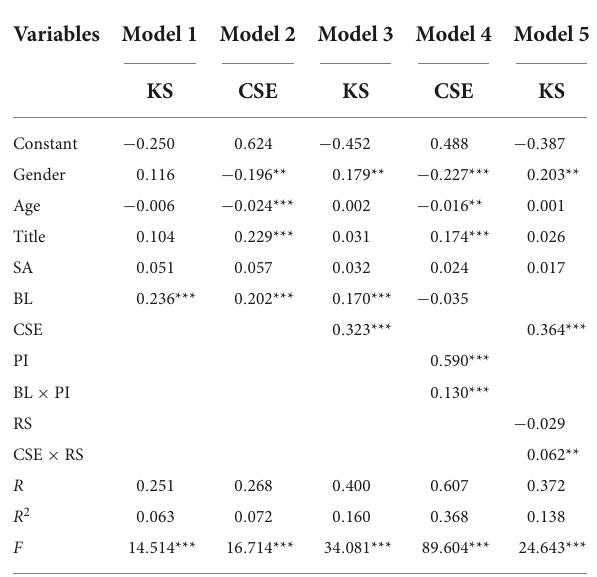
TABLE 4 Regression analysis results of mediating and moderating effects.